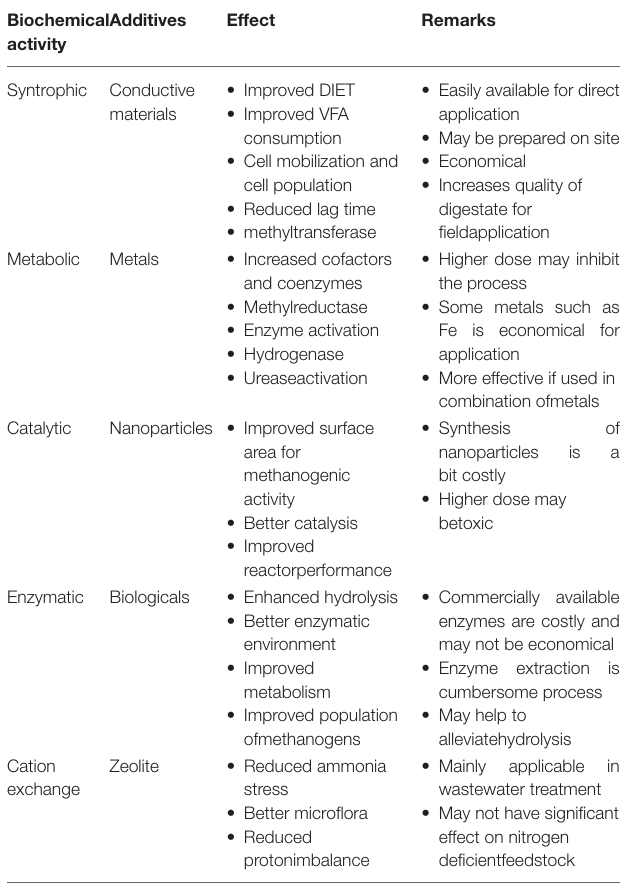
TABLE 5 | Comparison of additives for biochemical activity and their role in anaerobic digestion. Biochemical activity